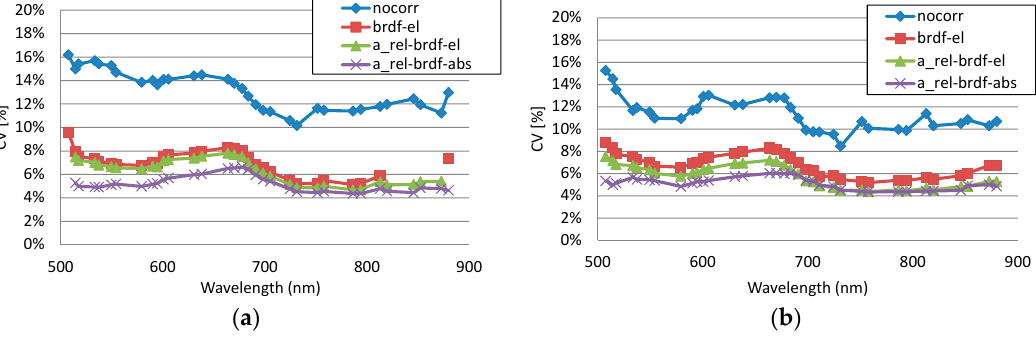
Figure 15. Coefficient of variation (CV) for the ( a ) full dataset and ( b ) flight f34 dataset. nocorr: no radiometric correction; brdf-el: empirical line based reflectance transformation separately for each flight and BRDF correction; a_rel-brdf-el: empirical line based reflectance transformation separately for each flight and BRDF and relative image-wise correction; a_rel-brdf-abs: full radiometric block adjustment with absolute calibration and BRDF and relative image-wise correction.